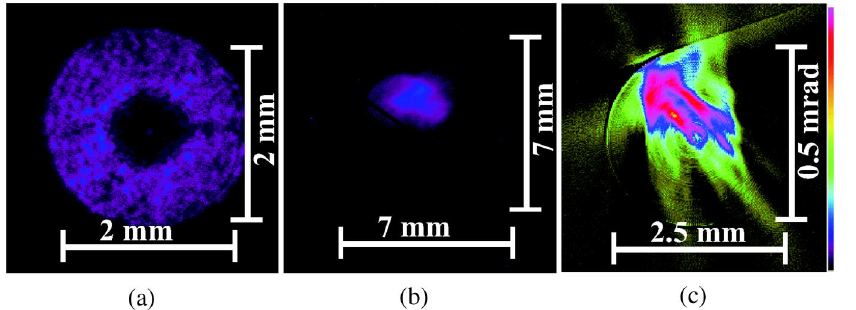
FIG. 9. (Color) ‘‘Donut’’ distribution. (a) The laser intensity profile, (b) the electron beam profile at HPOP-UP1 location, (c) the tomographic recovery of the electron beam’s transverse phase space.